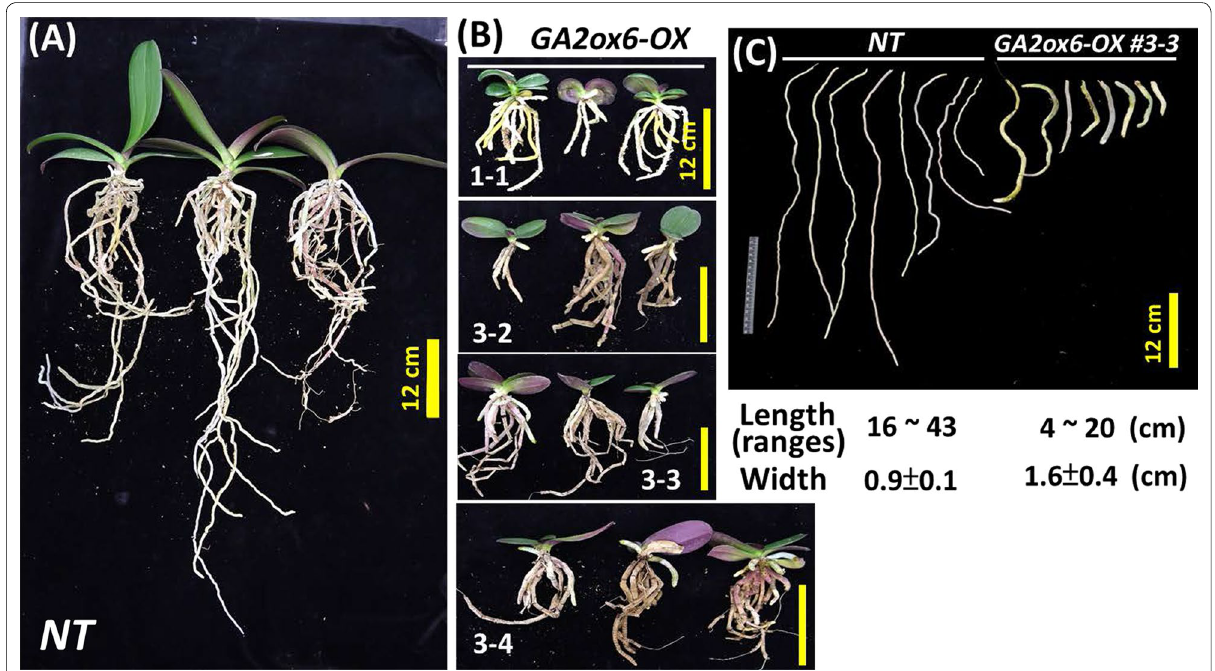
Fig. 4 Phenotypic comparisons of roots of the NT and GA2ox6 ‑ OX transgenic lines. a Three plantlets of NT control plants showing longer roots. b Three plantlets from each of the four GA2ox6 ‑ OX transgenic lines (#1‑1, #3‑2, #3‑3, and #3‑4) showing shorter roots. Bar the lengths and widths of roots dissected from the NT line and representative GA2ox6 ‑ OX transgenic line #3‑3 are shown. The ranges of root length and average root width measured for the dissected roots are provided below the